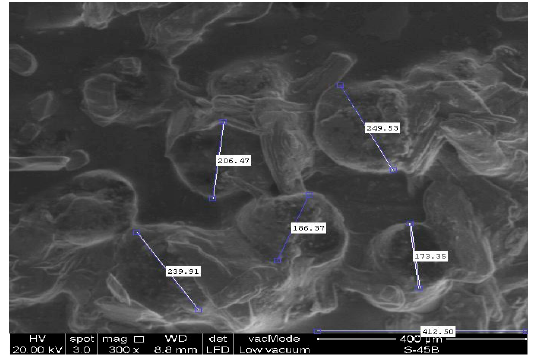
Figure 5. SEM image of ADN produced by melt prilling and coating with 5 wt % polystyrene (PS).